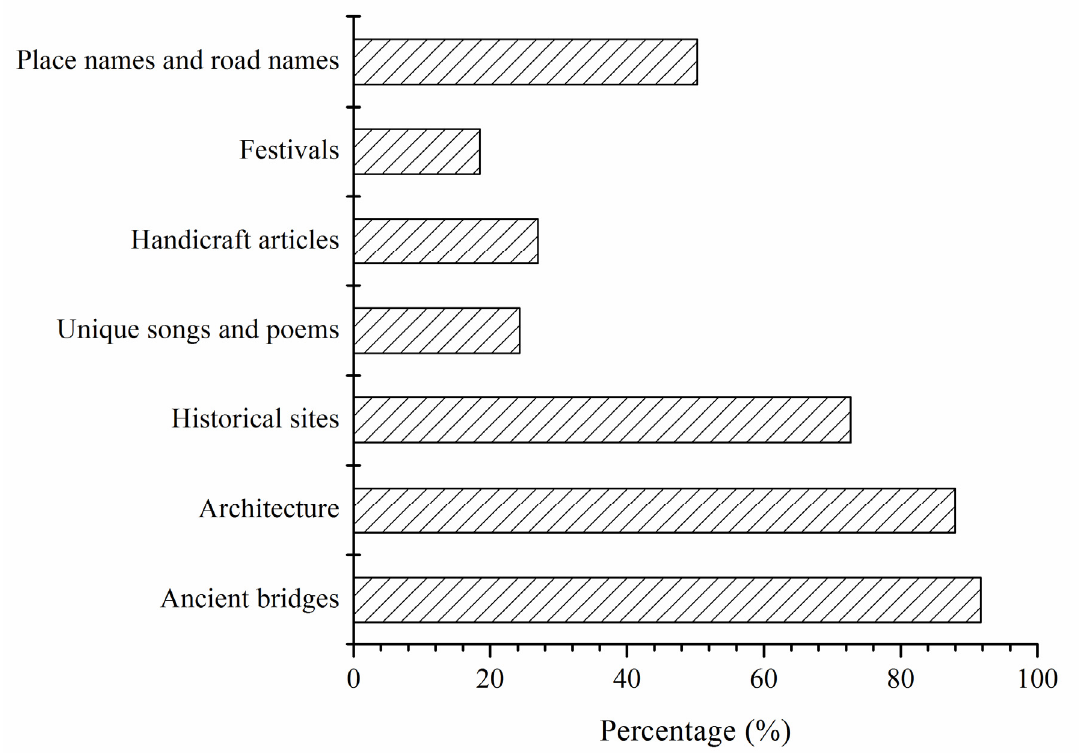
Figure 6. Respondents’ awareness of disappearance of cultural elements related to the river network.